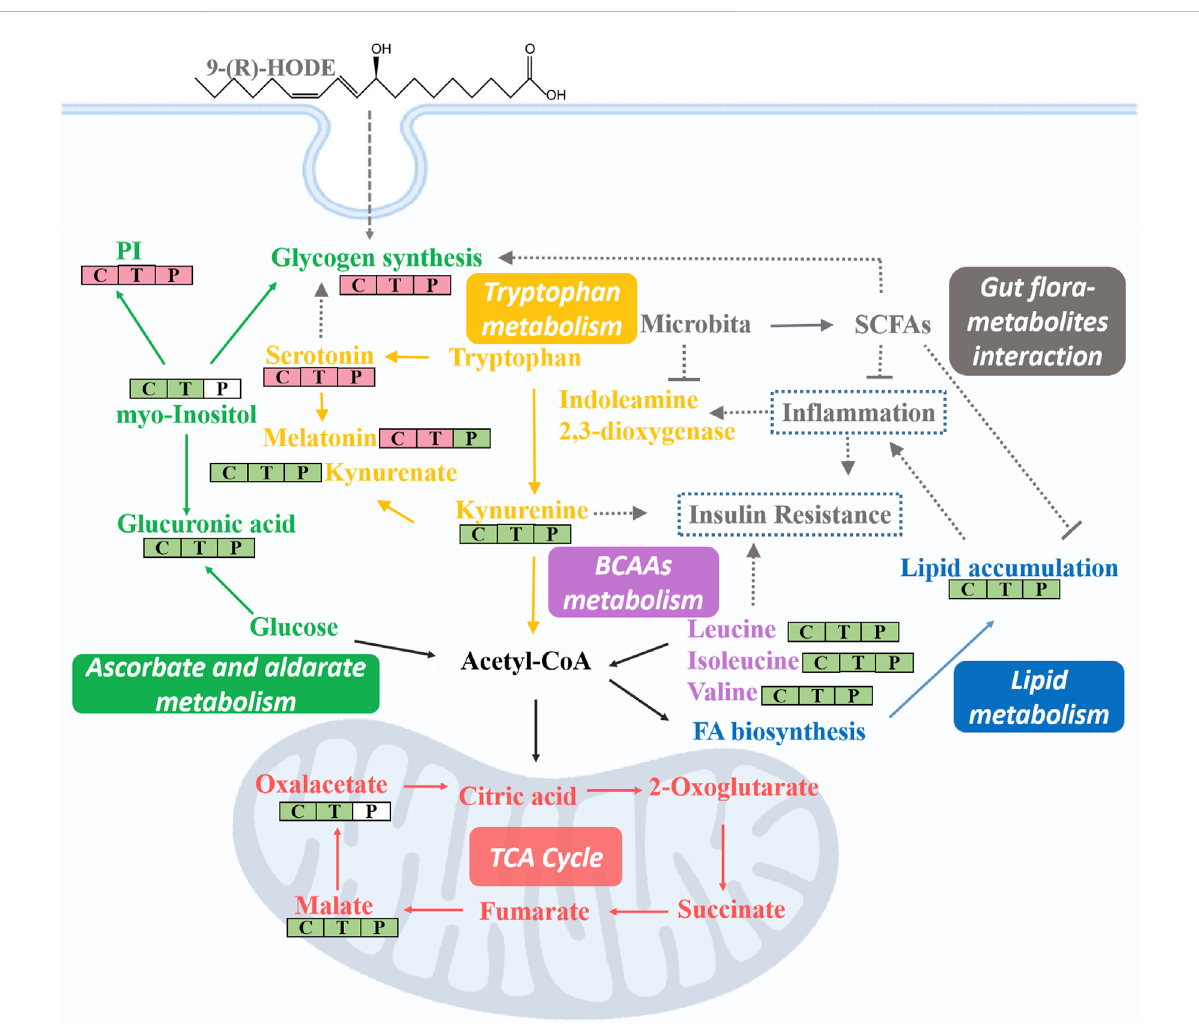
FIGURE 10 Representativeimagesoftissuemetaboliteionsdetectedbydesorptionelectrosprayionization-massspectrometryimaging(DESI ‒ MSI). (A) Ion imagesofkynurnine,glucuronicacid,LPC(18:2),TAG(53:2),andTAG(51:1)inlivers. (B) Ionimagesofkynurenine,myo-inositol,PE(O-38:5),PE(37:2) and PG (34:0) in kidneys. (C) Ion images of kynurnine, valine, melatonin and PI(38:3) in muscles. +: positive mode and -: negative mode. In each image, sections are ordered from left to right by model group, 9-(R)-HODE treatment group, control group and positive group. Scale bar is 4 mm. All ion images are normalized to the TIC, and the blue-to-yellow gradient color scheme refers to low-to-high